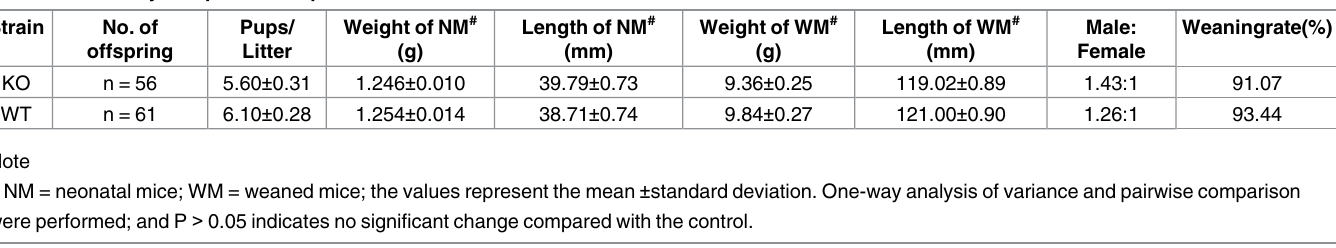
Table 2. Changes in body weight.